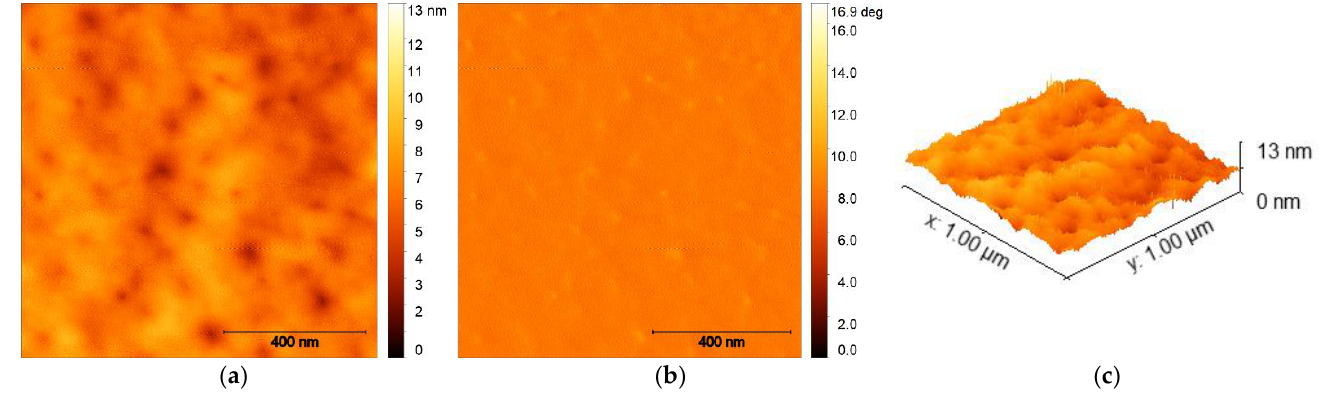
Figure 11. AFM topography of SQ 5c :PC 71 BM blends that are spin-coated from a 20 mg mL −1 solution in chloroform at 2000 rpm: ( a ) height, ( b ) phase, and ( c ) height, 3D view.